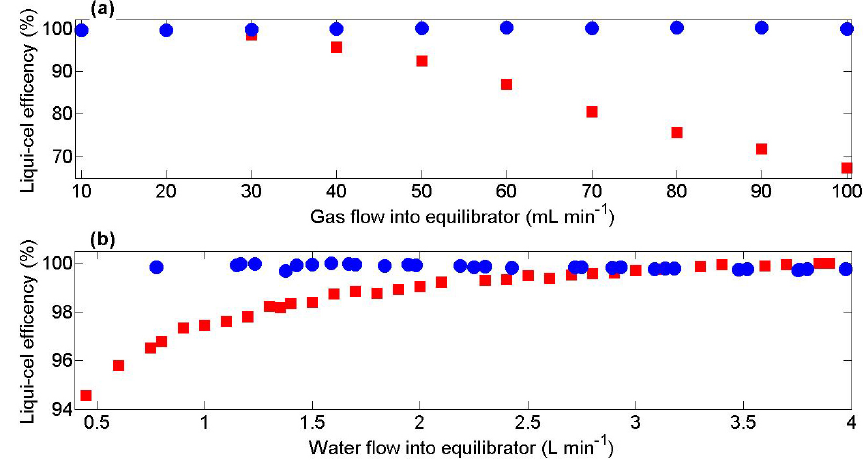
Figure 3. Liqui-Cel CO 2 equilibration efficiency (Liqui-Cel mixing ratio/showerhead mixing ratio) for (a) changing gas flow at a fixed water flow rate of 4Lmin − 1 and (b) changing water flow at a fixed gas flow of 100mLmin − 1 . Blue: unfouled equilibrator. Red: fouled